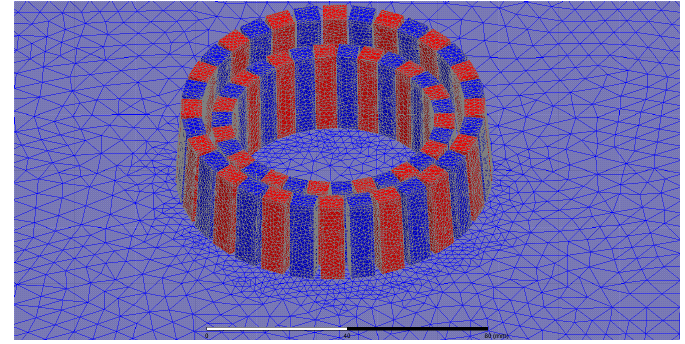
Figure 8. Distribution of the finite elements.